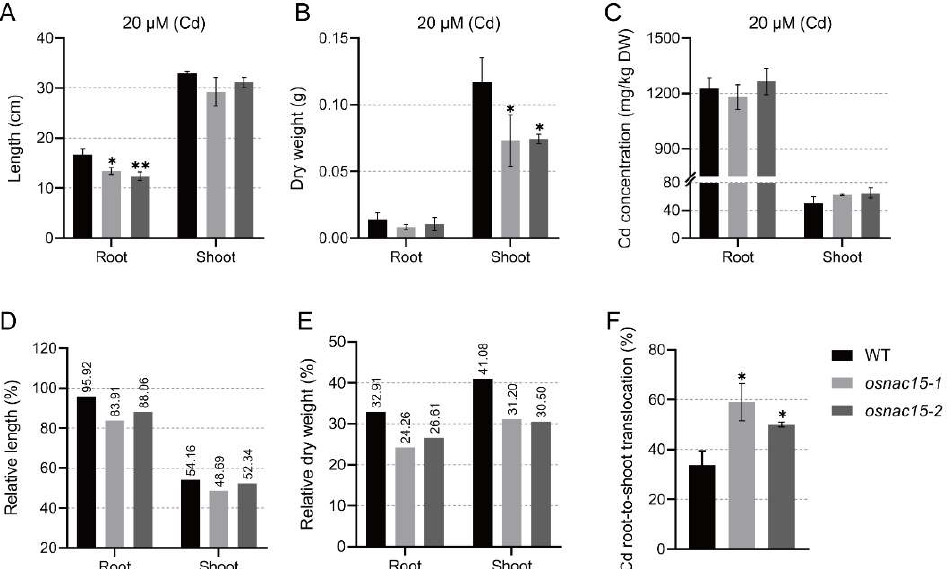
Figure 4. Phenotypic analysis of OsNAC15 knockout lines for CDT. Length ( A ), dry weight ( B ), Cd concentration ( C ), relative length ( D ), relative dry weight ( E ) of roots and shoots and Cd transloca- tion from root to shoot ( F ) in the WT and knockout lines. The plants were grown in a 1/2 KB solution with or without 20 µM CdCl 2 for 18 days. Data are represented as means ± SD of three biological replicates. * and ** indicate significant differences at p < 0.05 and 0.01, respectively, by Student’s t - test.